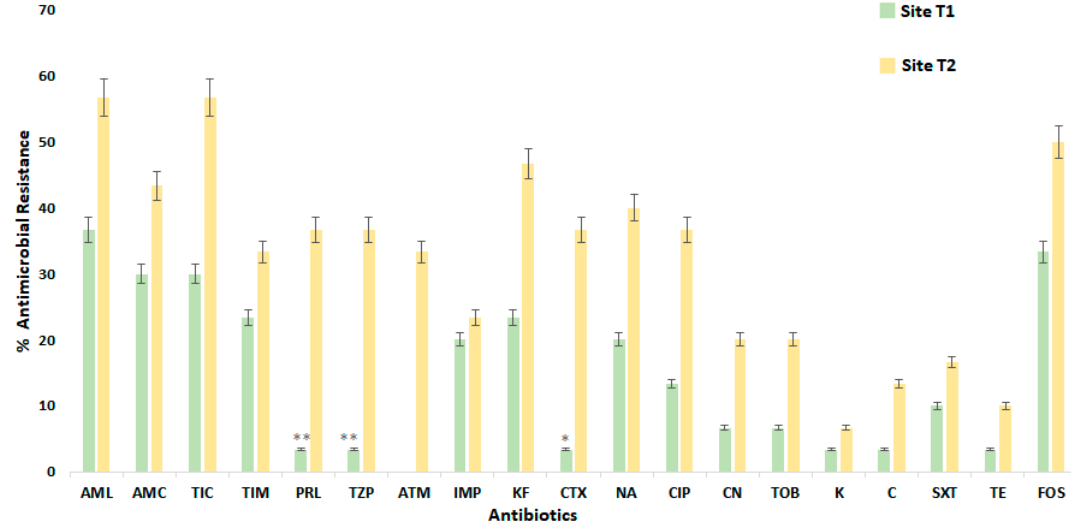
Figure 3. Percentage of antimicrobial-resistant bacteria along the river: Site T1 (green) and Site T2 (yellow). Values were expressed as the mean of resistant Aeromonas spp. ± standard deviation, for the same antimicrobial. * and ** indicate significant differences between different locations (sites T1 and T2) within the same antimicrobial (ANOVA followed by Tukey’s test at p < 0.05 and p < 0.01, respectively). Antibiotic abbreviations: AML—amoxicillin; AMC—amoxicillin/clavulanic